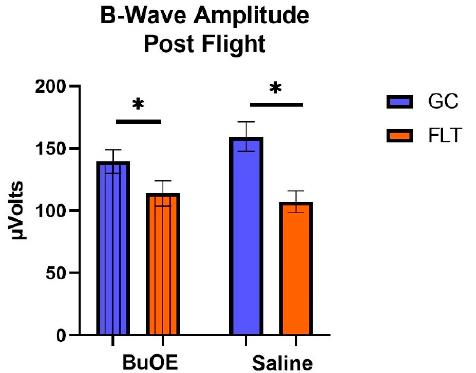
Figure 8. The post-flight comparison of the retina light sensitivity to the b-wave in saline or BuOE- treated flight (FLT) and habitat control (GC) groups. * Significantly different between flight and control ( p < 0.05). Bars represent the mean ± SEM (n = 8).